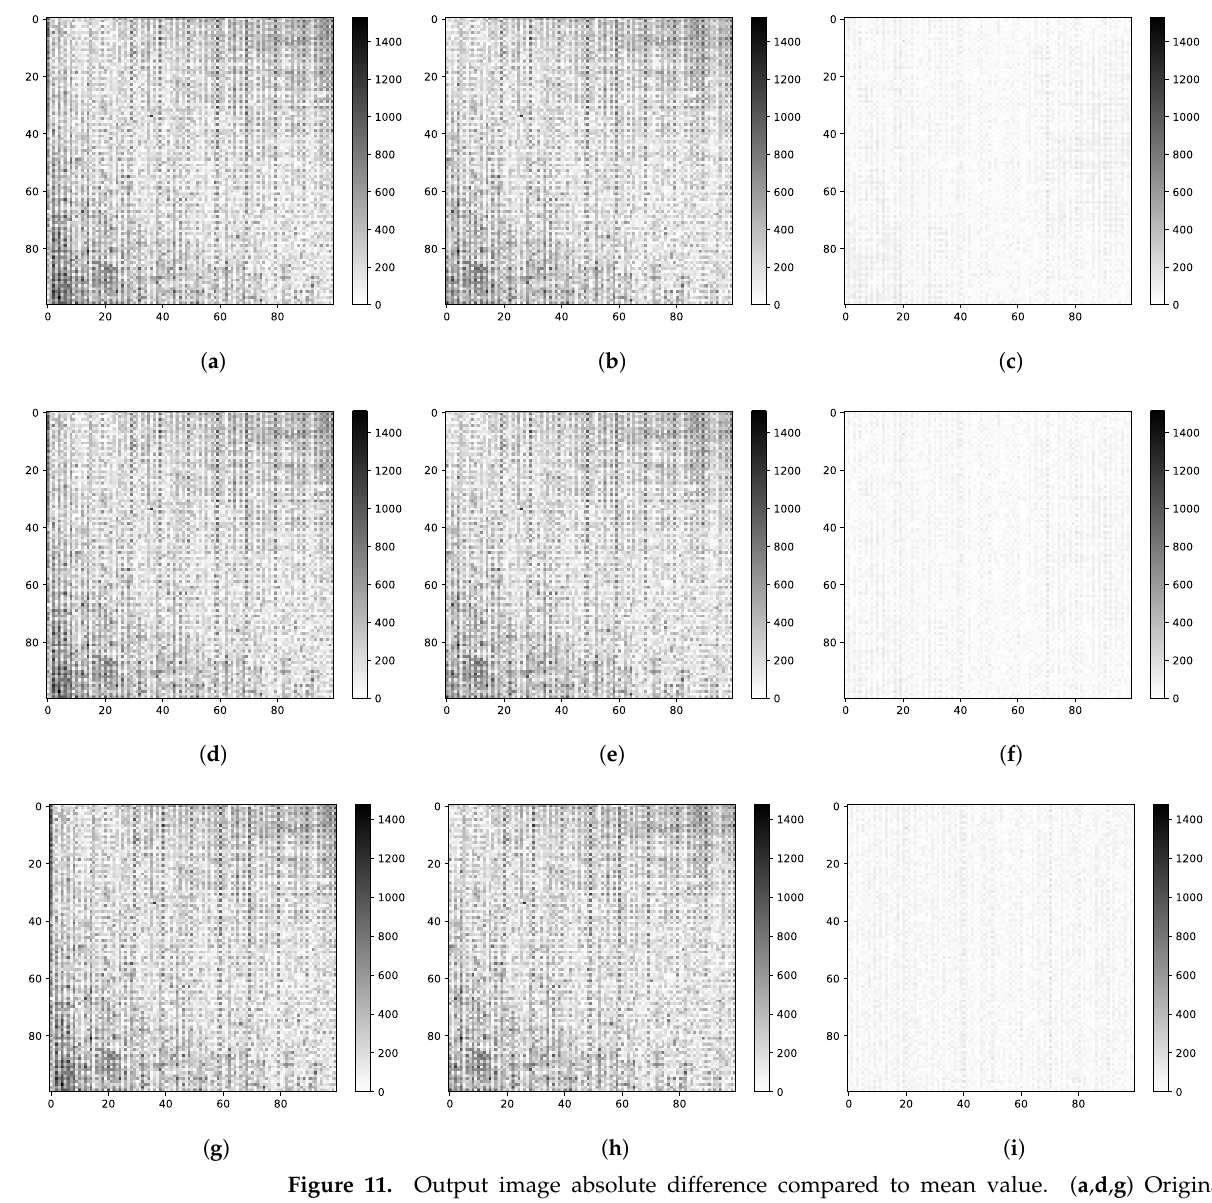
Figure 11. Output image absolute difference compared to mean value. ( a , d , g ) Original im- age without corrections. ( b , e , h ) Image after temperature compensation. ( c , f , i ) Image after non- uniformity correction. With, ( a ) 30°C, σ 2 v = 32,769.6 LSB, σ 2